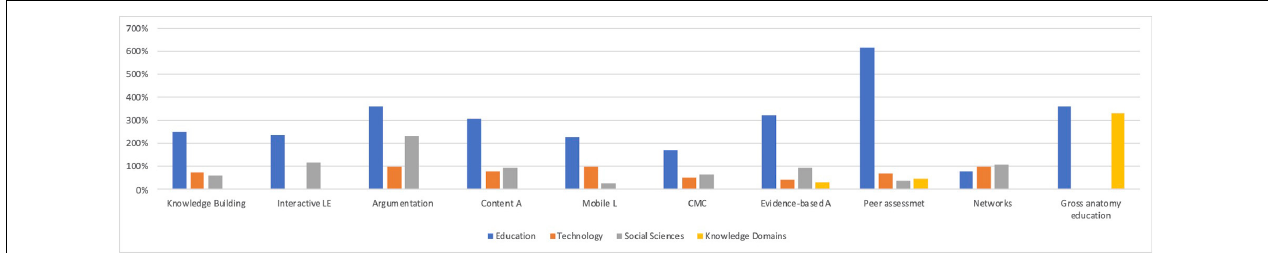
FIGURE 3 | Disciplinary composition of citing journals by